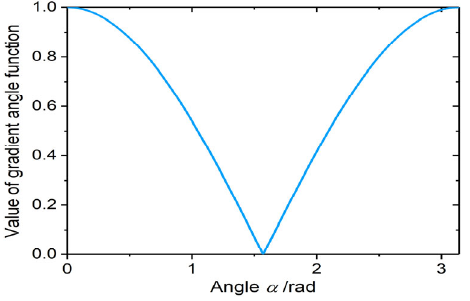
Figure 3. Gradient angle function curve.